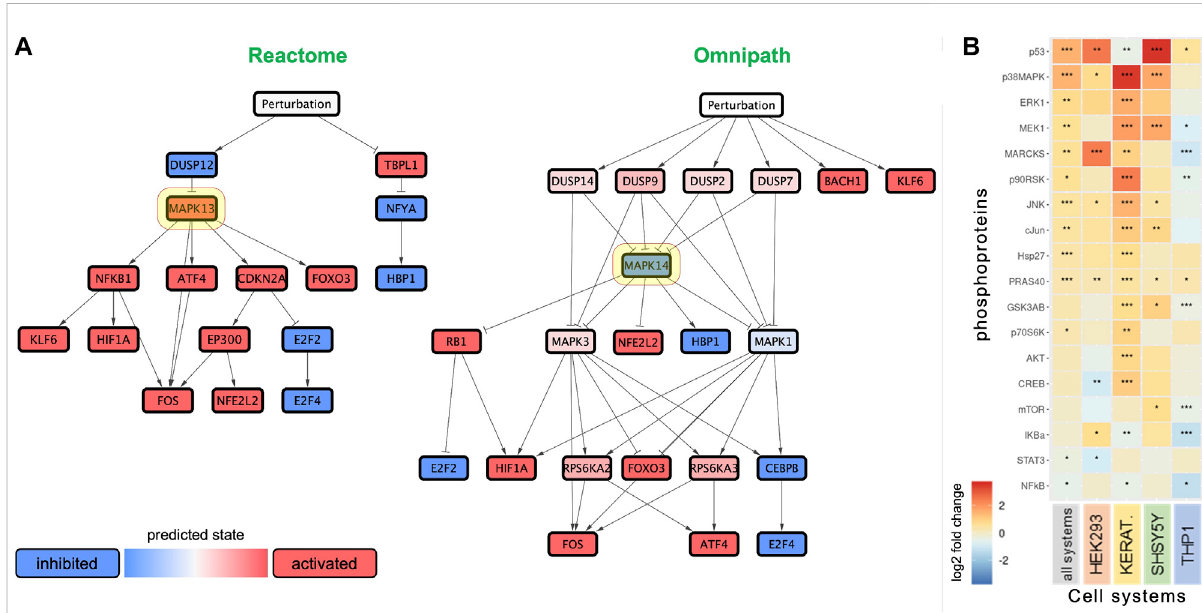
FIGURE 5 Anatabine treatment results in the activation of MAPK signaling. (A) Networks predicting the effect of anatabine, leveraging the biological knowledge networks Reactome and Omnipath. Red and blue nodes depict predicted upregulation and downregulation, respectively. Highlighted in yellow are the network nodes corresponding to p38 MAPK. (B) Effect of anatabine on phosphoproteomics across all tested cell systems, treatment times, and concentrations. The other four columns correspond to the data for each cell system separately. Phosphoproteins are ranked by median log2 fold change in each